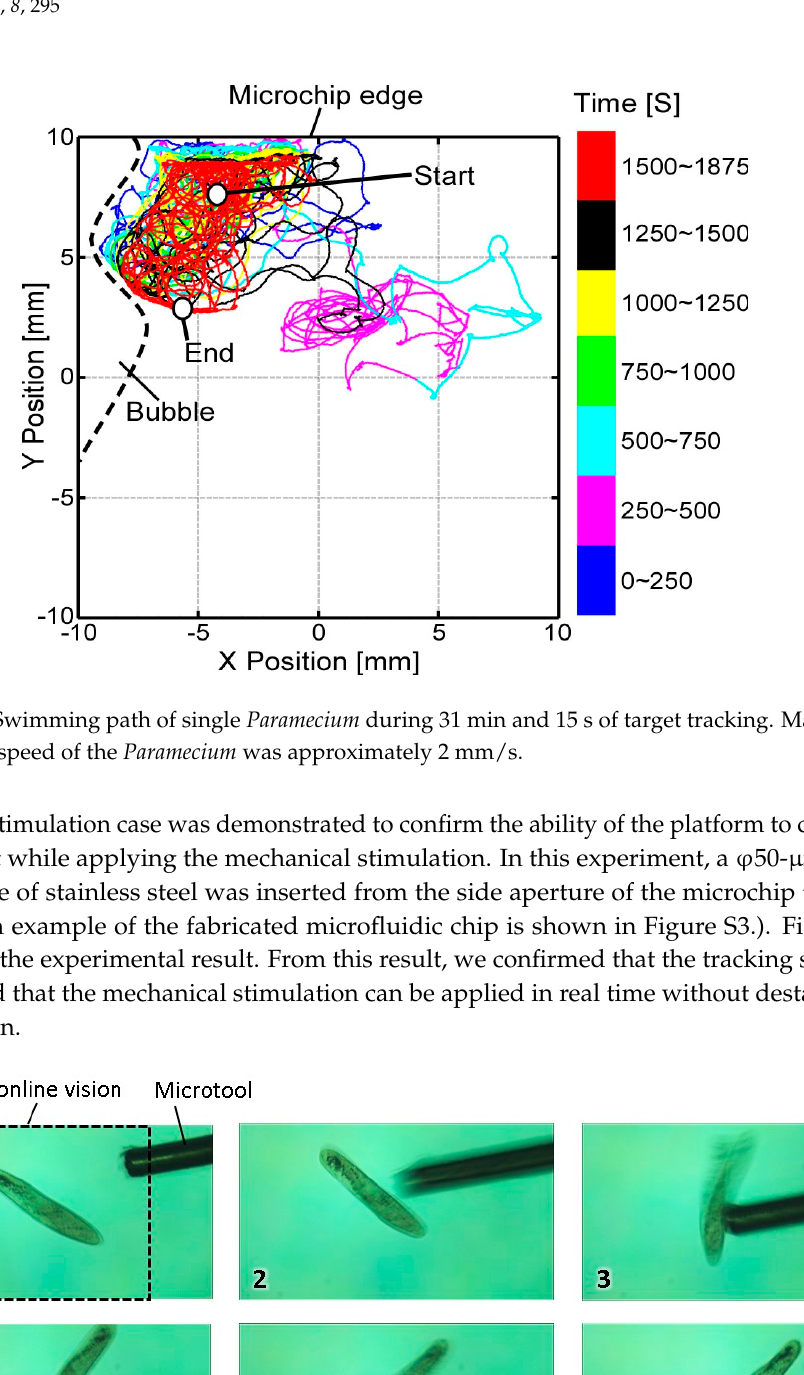
Figure 11. Experimental result for mechanical stimulation of swimming Paramecium.